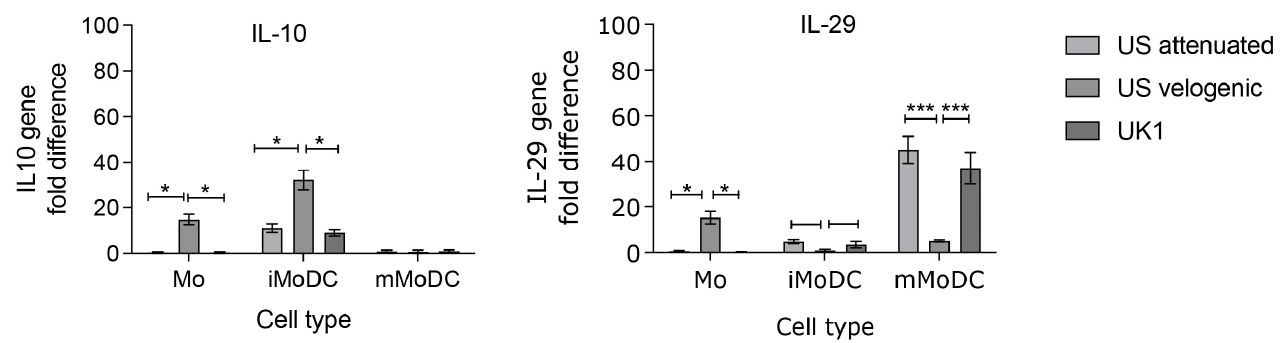
Bonferroni post-test was used to compare replicate means.